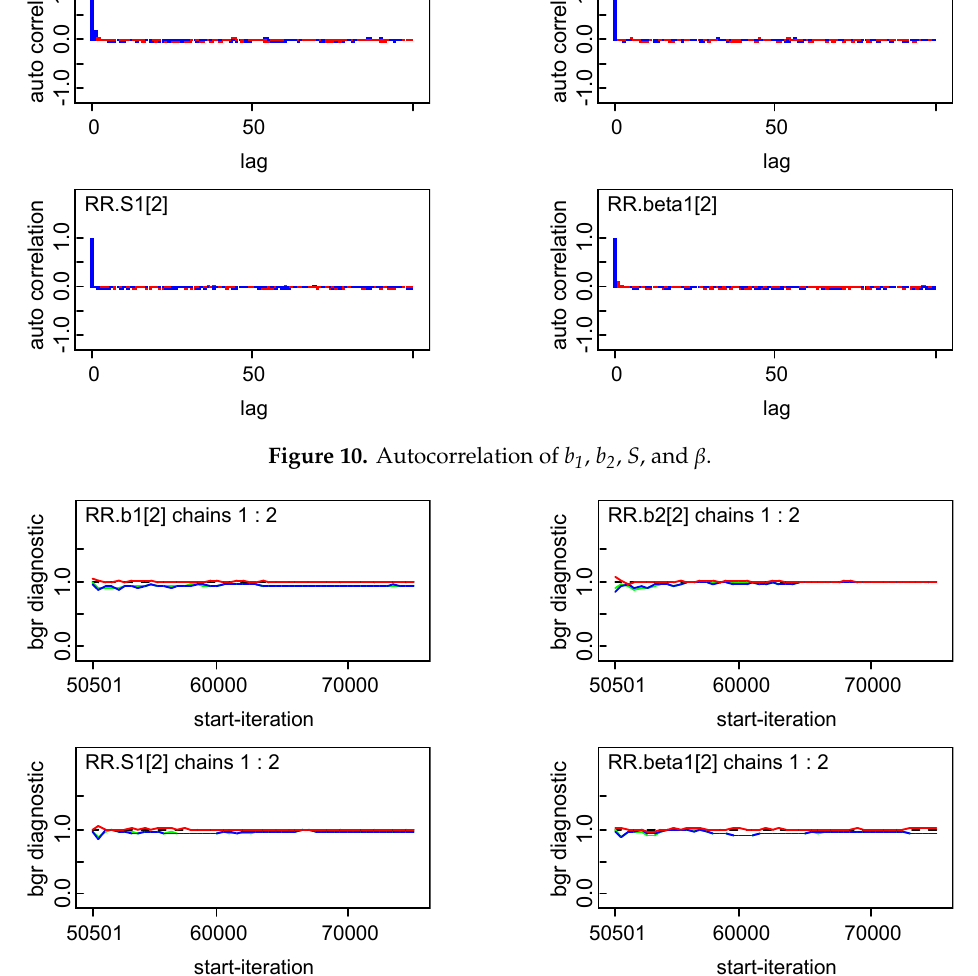
Figure 11. Convergence of b 1 , b 2 , S , and β .